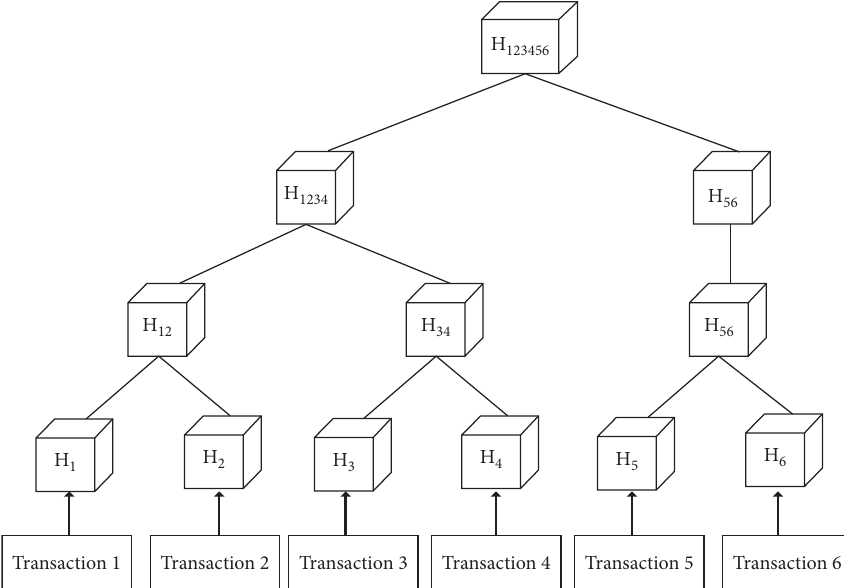
Figure 3: Merkle tree.